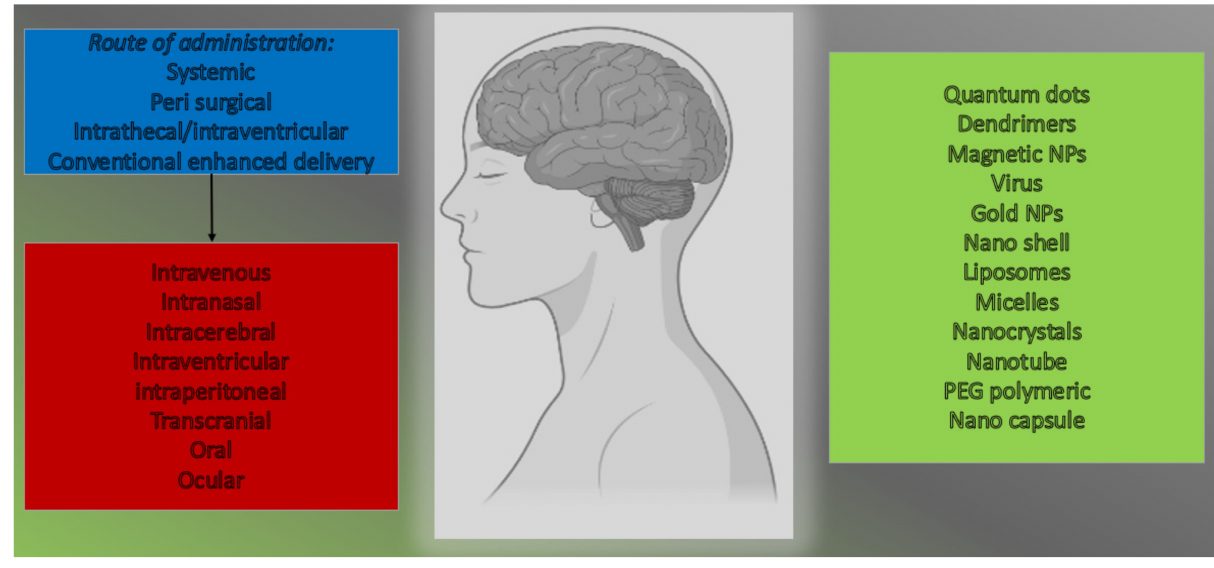
Figure 5. Possible route of administration to target the